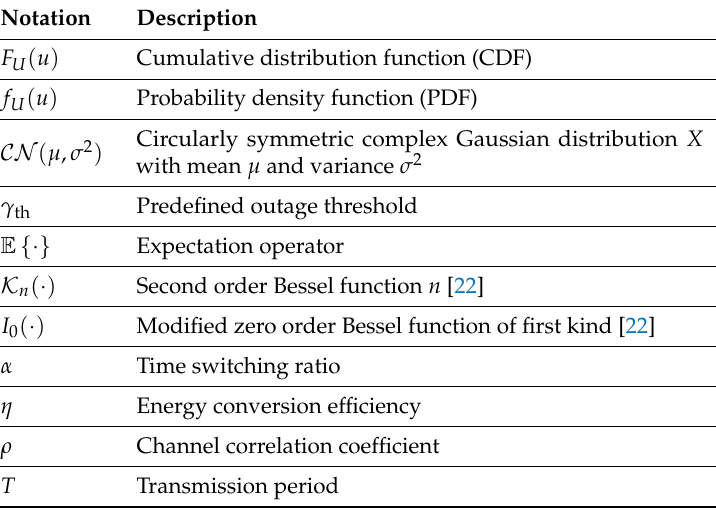
Table 1. The mathematical notations used in this